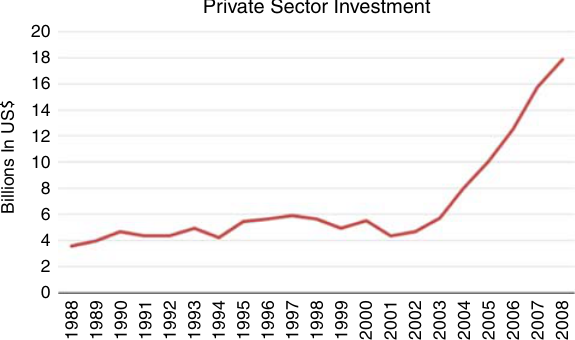
Figure 2. Illustration of private sector investment trend in EIC (data source is